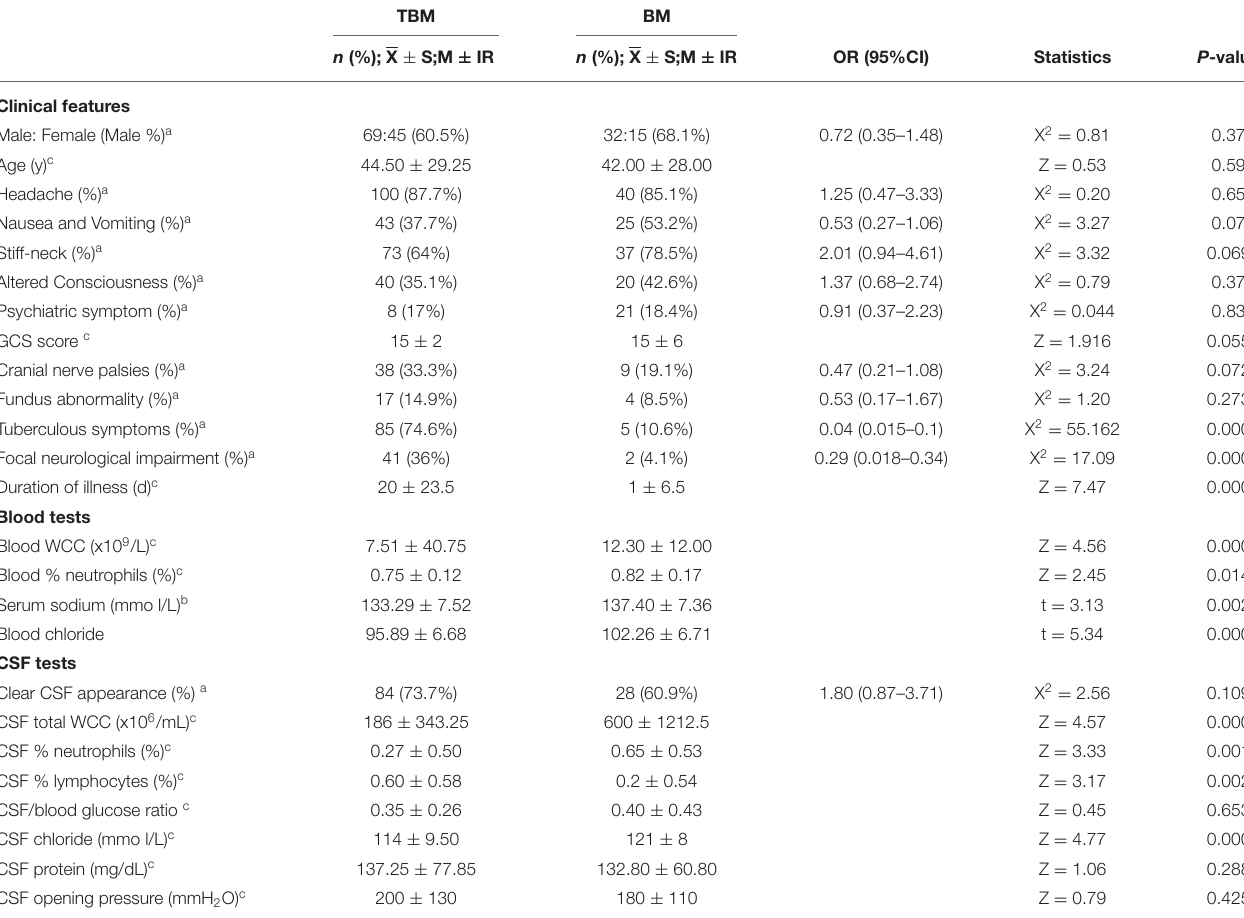
TABLE 3 | Univariate analysis, comparison of the clinical and laboratory characteristics in tuberculous meningitis (TBM) and bacterial meningitis (BM).